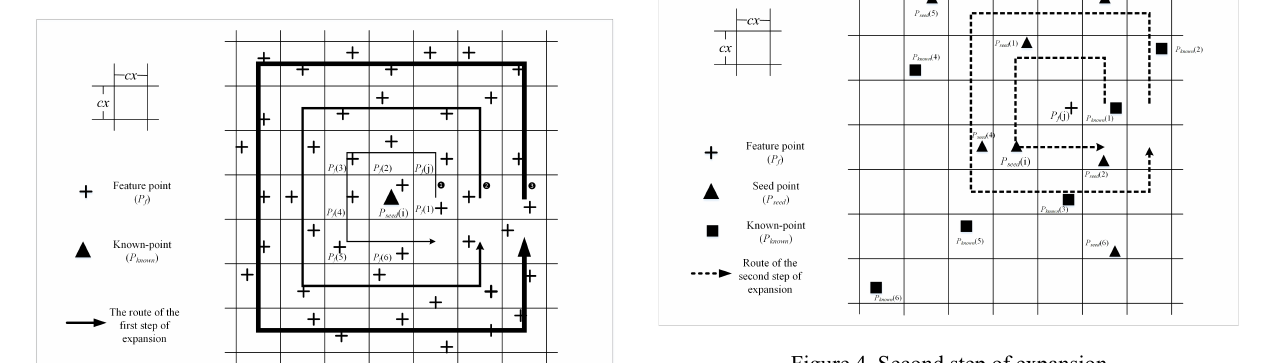
Figure 4. Second step of